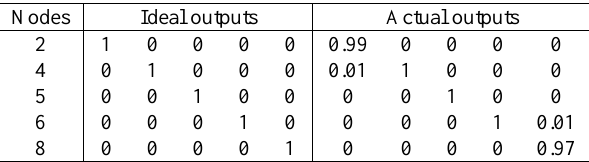
Table 10 Memory ability of fuzzy system for case 1